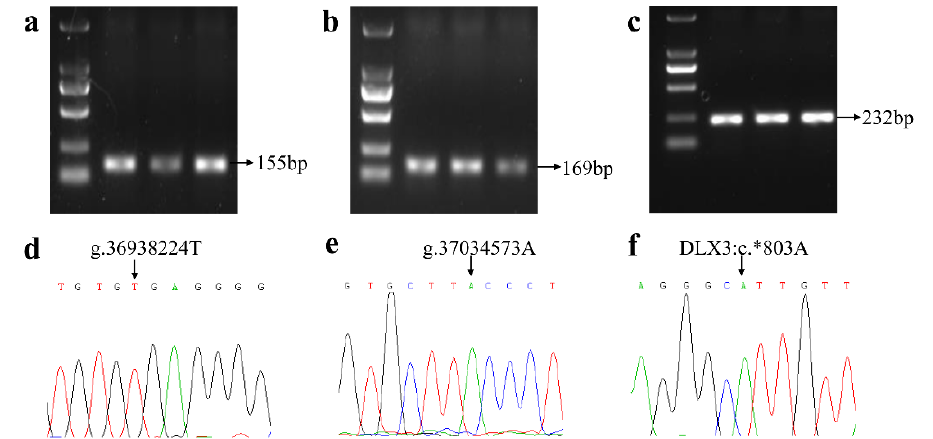
Figure 1. Target amplification bands for three specific mutations. ( a ) Target band amplified by P1 for the mutation g.36938224T > A. ( b ) Target band amplified by P2 for the mutation g.37034573A > G. ( c ) Target band amplified by P3 for the mutation DLX3:c. * 803A > G. ( d ) The sequencing result at the site of g.36938224T > A. ( e ) The sequencing result at the site of g.37034573A > G. ( f ) The sequencing result at the site of DLX3:c. * 803A > G.